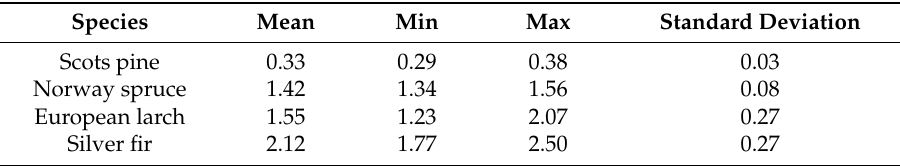
Table 4. Ash content in cones from the studied tree species (dry bases), in %wt.